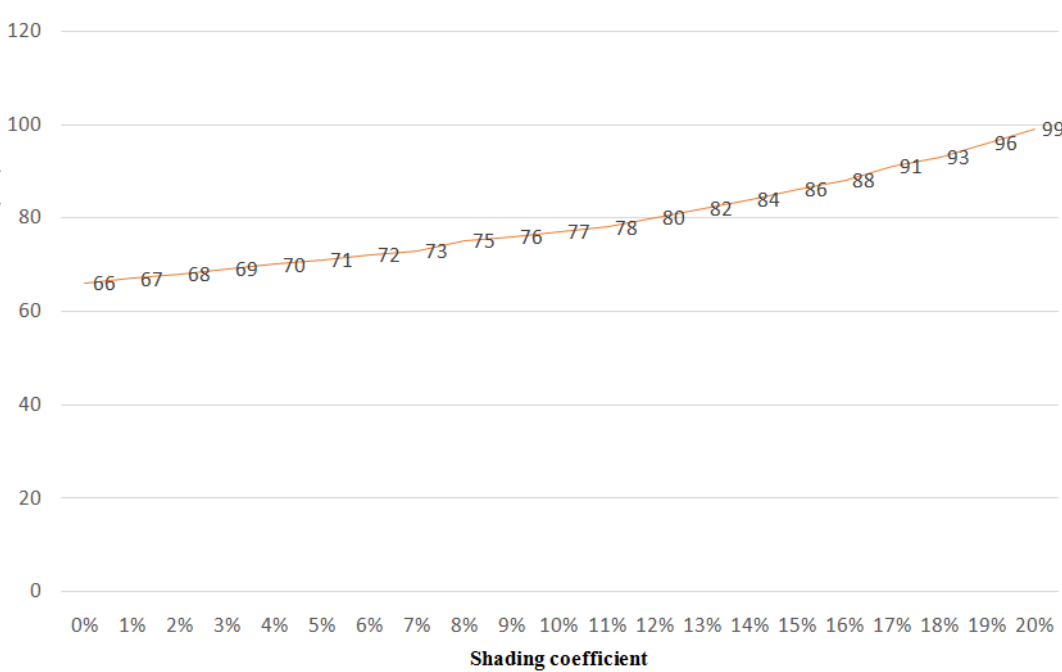
Fig. 4 Relationship between shading coefficient and minimum insulation thickness.